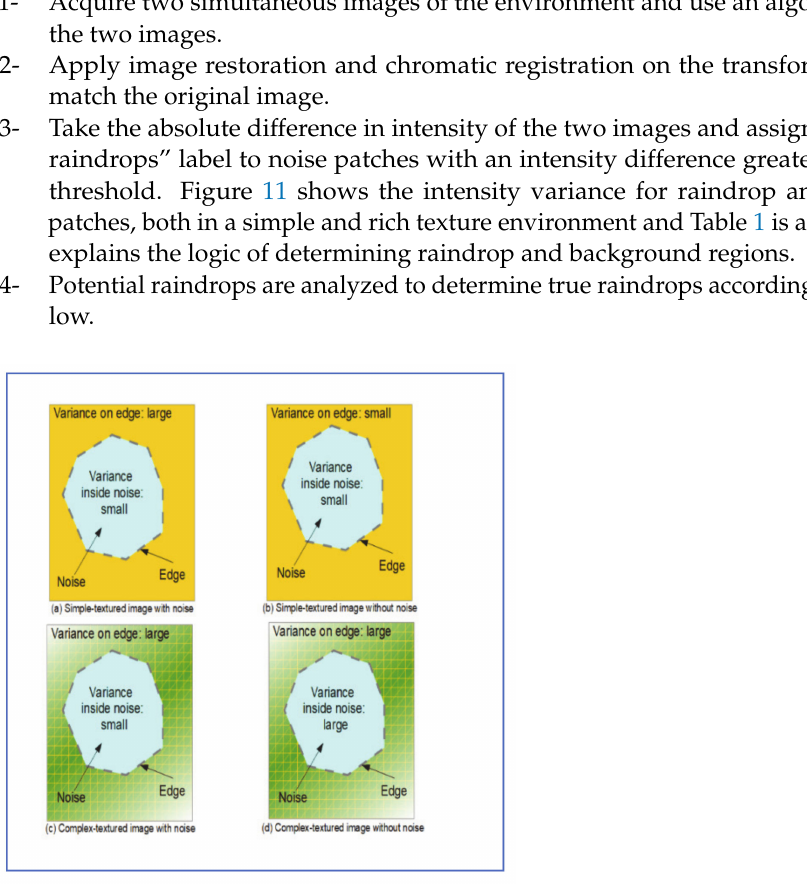
Figure 11. Intensity variance can be used to distinguish raindrop regions from background noise [28]. Table 1. Truth Table to Distinguish True Raindrop from Background